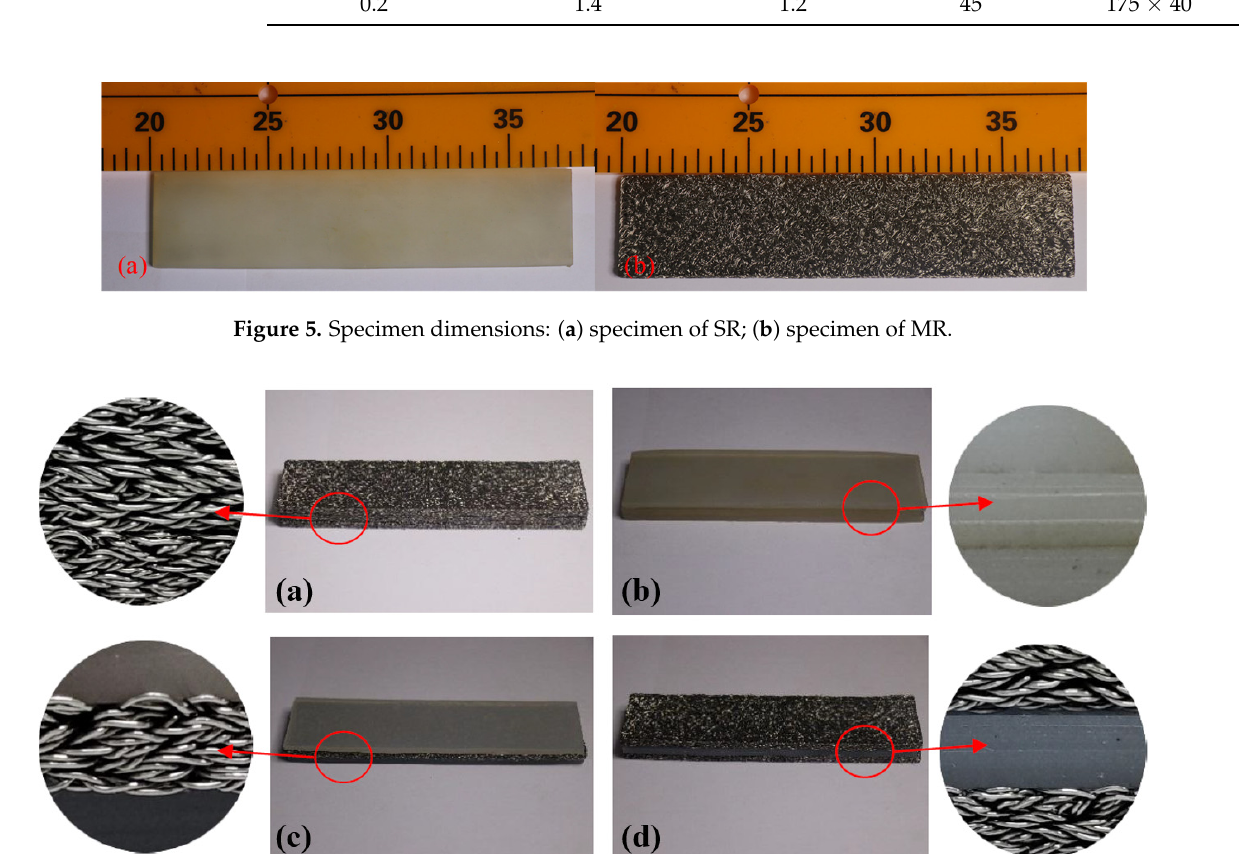
Table 3. MR preparation parameters.